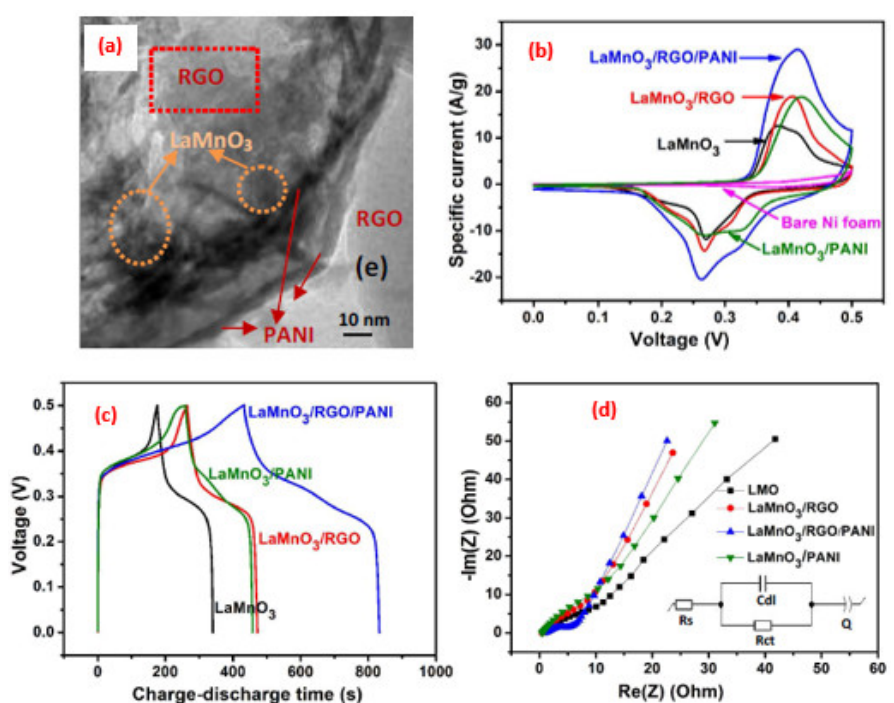
Figure 1. ( a ) HRTEM images of LaMnO 3 /reduced graphene oxide/polyaniline; ( b ) CV curve recorded at a scan rate of 10 mVs − 1 for all samples and at 20 mVs − 1 forNi foam; ( c ) Charge–discharge curve recorded for all samples at a current density of 1mA g − 1 ; and ( d ) Nyquist plots for all electrodes. Copyright 2018 by the American Chemical Society [45].